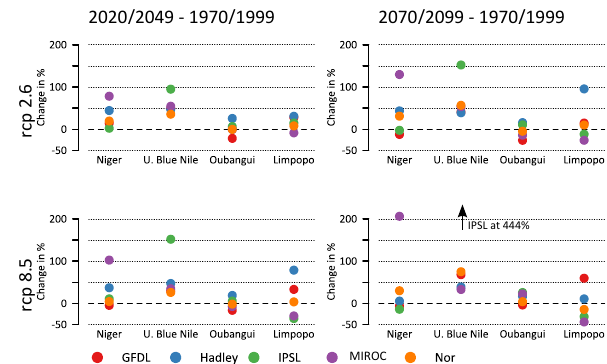
Fig. 10. Change in Q 90 (low flows) of five bias corrected model projections in near (2020–2049, left column) and far (2070–2099, right column) scenario periods compared to the reference period (1970–1999) for RCP 2.6 (upper row) and RCP 8.5 (lower row) in